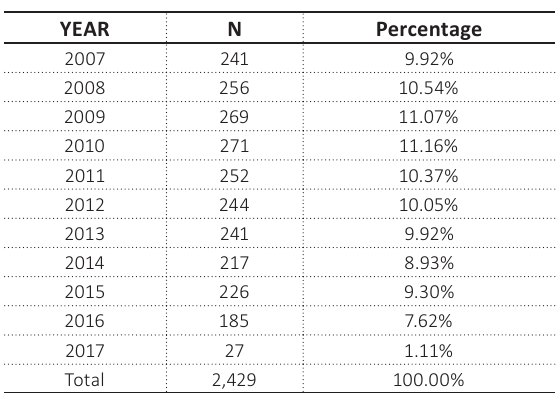
Table 3. Distribution of the sample by